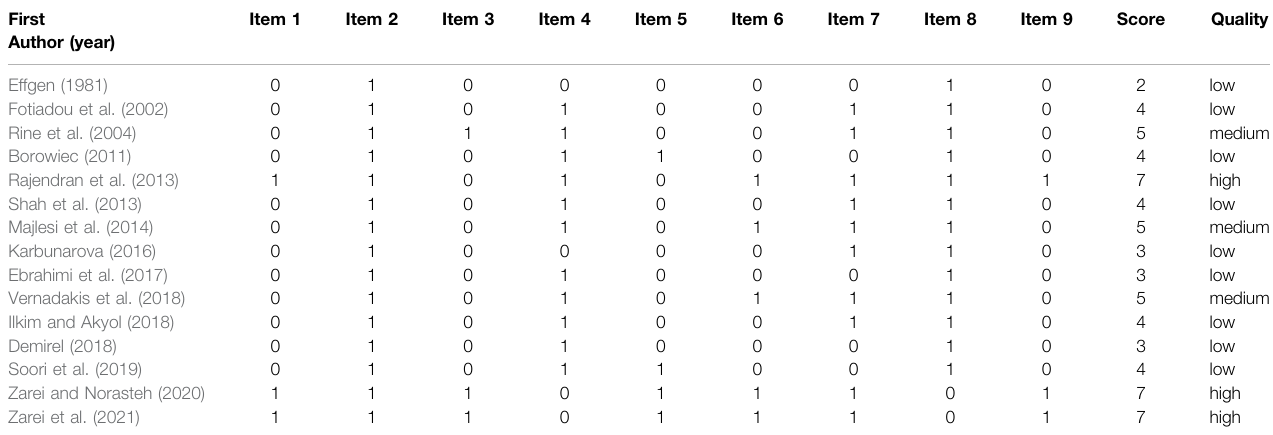
TABLE 2 | Results of study quality evaluation of included